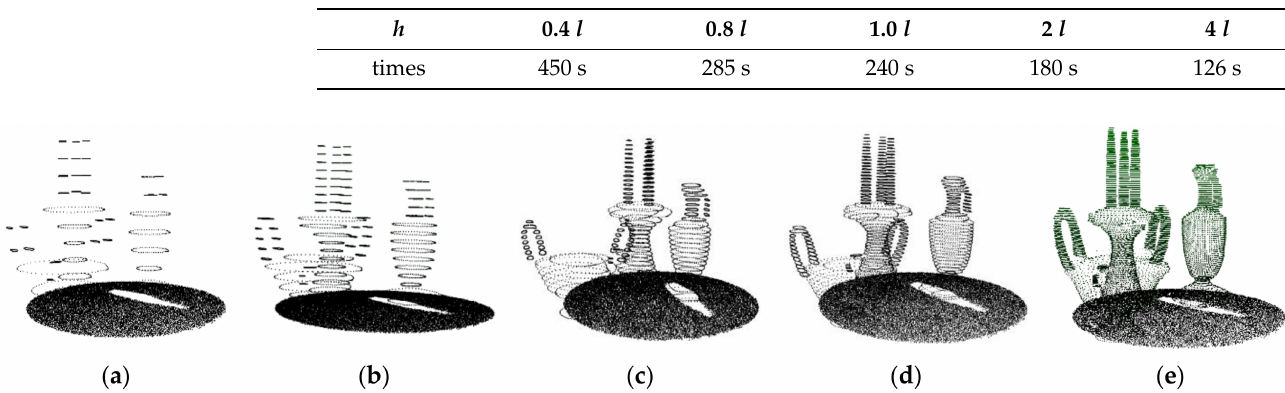
Figure 4. Experimental results of h : ( a ) l = 0.34 d dens , h = 4 l ; ( b ) l = 0.34 d dens , h = 2 l ; ( c ) l = 0.34 d dens , h = 1.0 l ; ( d ) l = 0.34 d dens , h = 0.8 l ; ( e ) l = 0.34 d dens , h = 0.4 l .